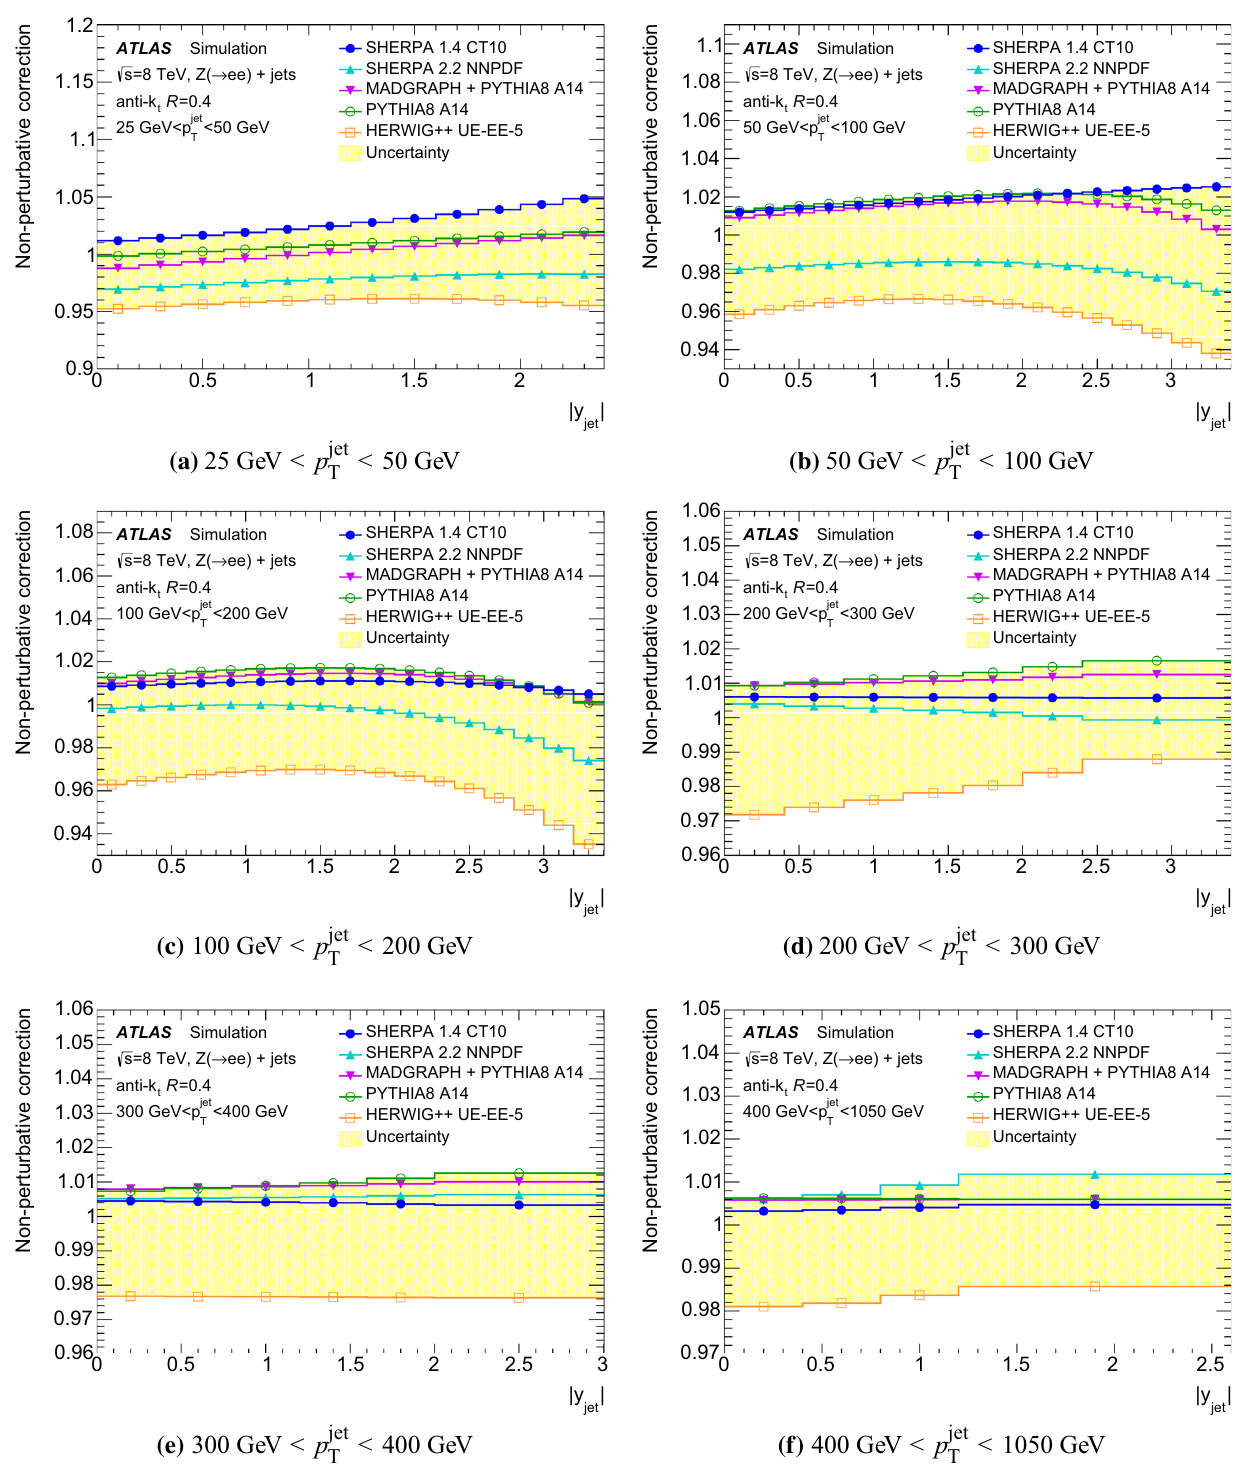
Fig. 3 The non-perturbative correction for the Z + jets production cross-section as a function of | y jet | in p jet represents the